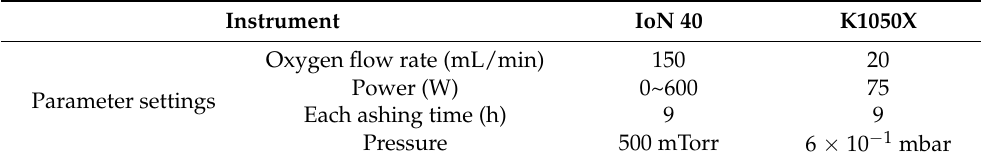
Table 1. Operating parameters of the two plasma